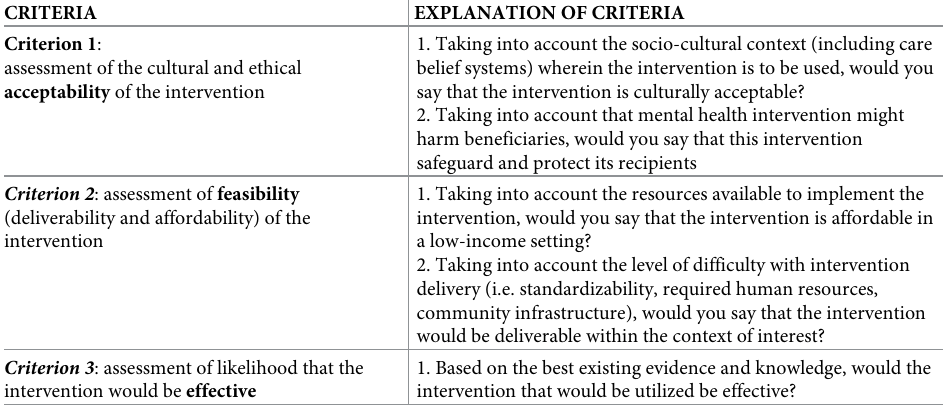
Table 1. Pre-determined criterion questions used by the expert panel as recommended by